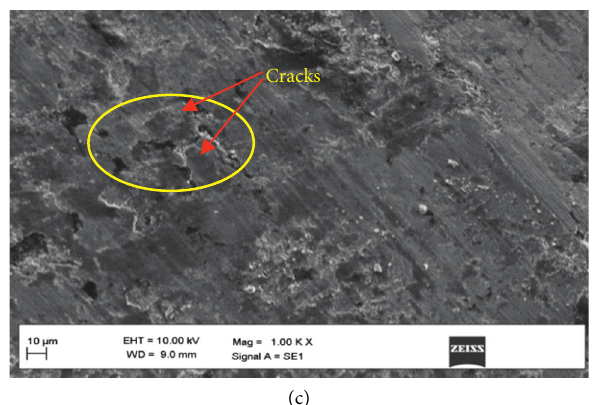
Figure 10: SEM micrograph of wear track morphology on the worn-out surface obtained at 0.17m/s sliding speed and 1.5kgf normal load for (a) Al 2 O 3 +3 wt%TiO 2 +1 wt% CNTreinforced coating, (b) Al 2 O 3 +3wt%TiO 2 +3wt% CNTreinforced coating, and (c) Al 2 O 3 +3wt% TiO 2 +5wt% CNT reinforced